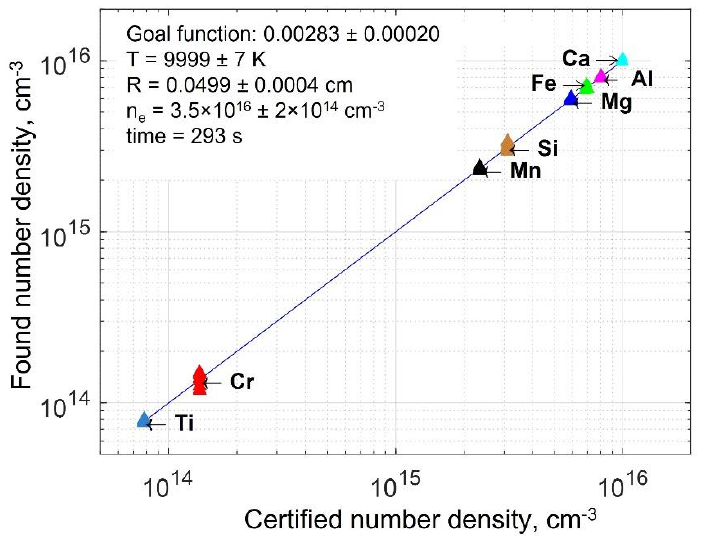
Figure 3. Certified–found correlation plot for synthetic slag spectrum. Each element is represented by 11 colored triangles (some are completely merged) corresponding to 11 runs that started from a random configuration. Table 3. Accuracy and precision of MC analysis; % concentrations of elements are recalculated from concentrations of oxides given in Table 1.